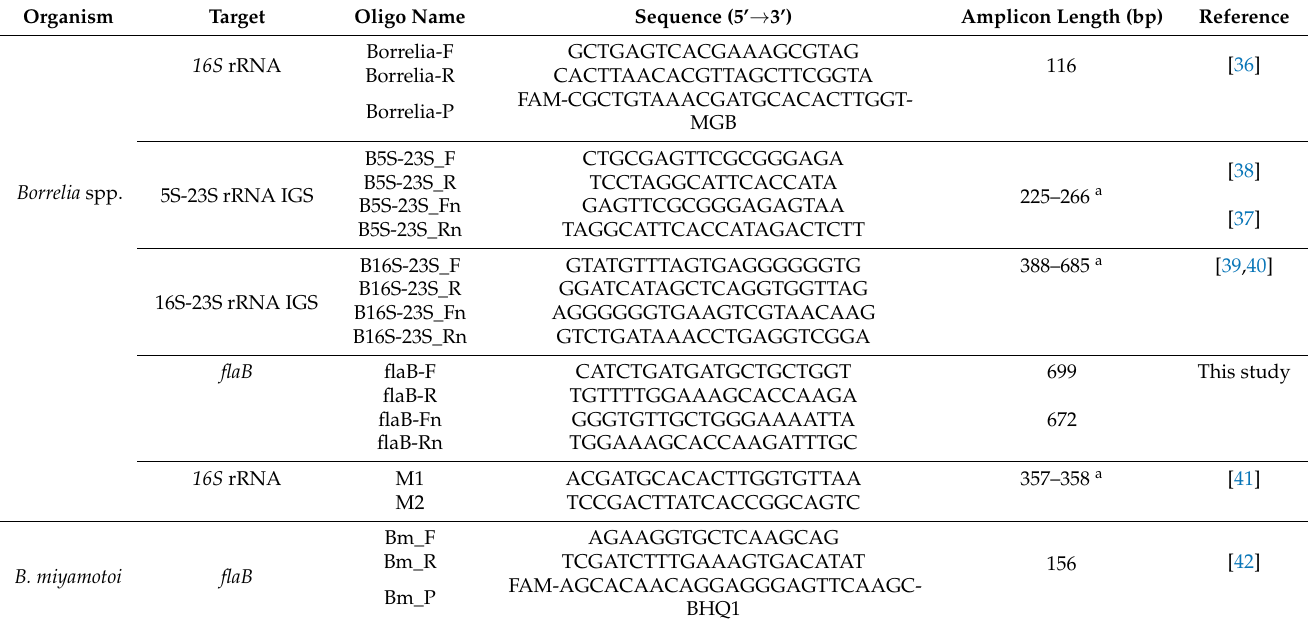
Table 1. Primers and probes used for molecular analysis of Borrelia